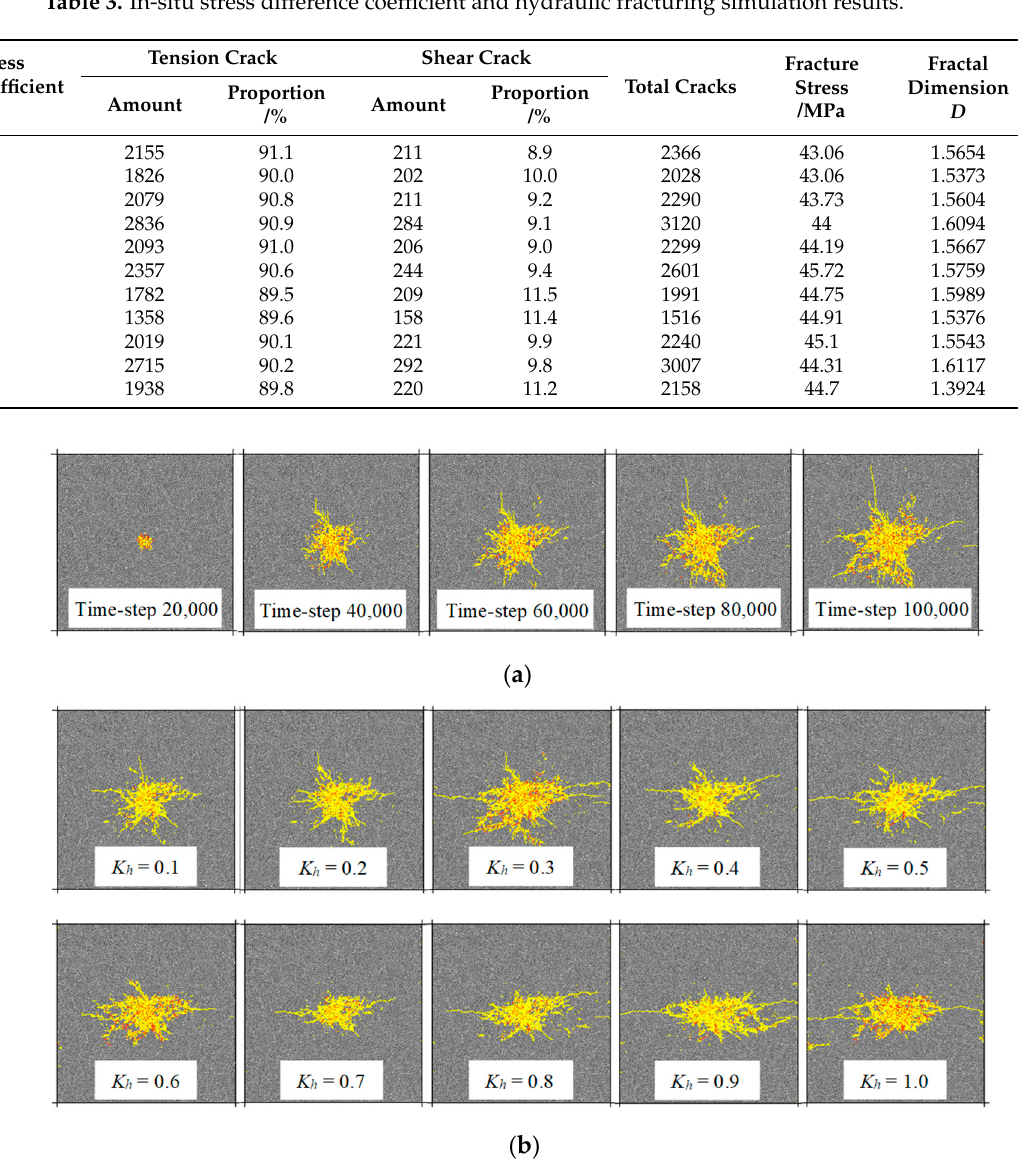
Table 3. In-situ stress difference coefficient and hydraulic fracturing simulation results.